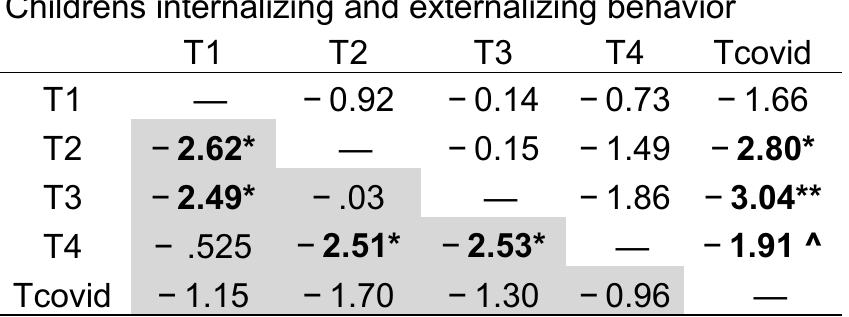
Table 2. Z values for post-hoc pairwise comparisons on longitudinal changes in children’s internalizing (grey columns) and externalizing (white columns) behavior). ^ p = .056; * p < .05; ** p < .005 (Bonferroni